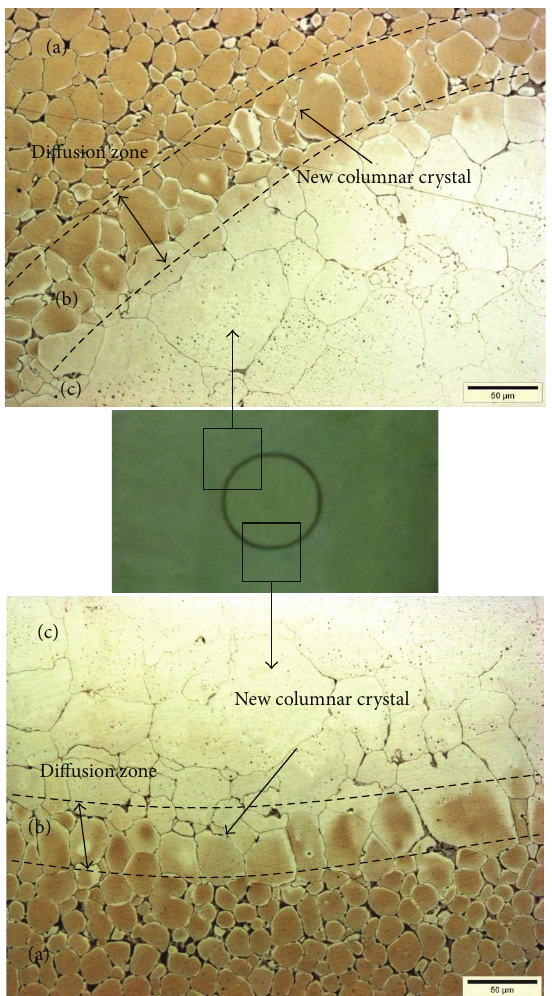
Figure 7: Microstructures of thixojoint of (a) AISI D2, (b) diffusion zone, and (c) AISI 304 after application of 1320 ∘ C for 30